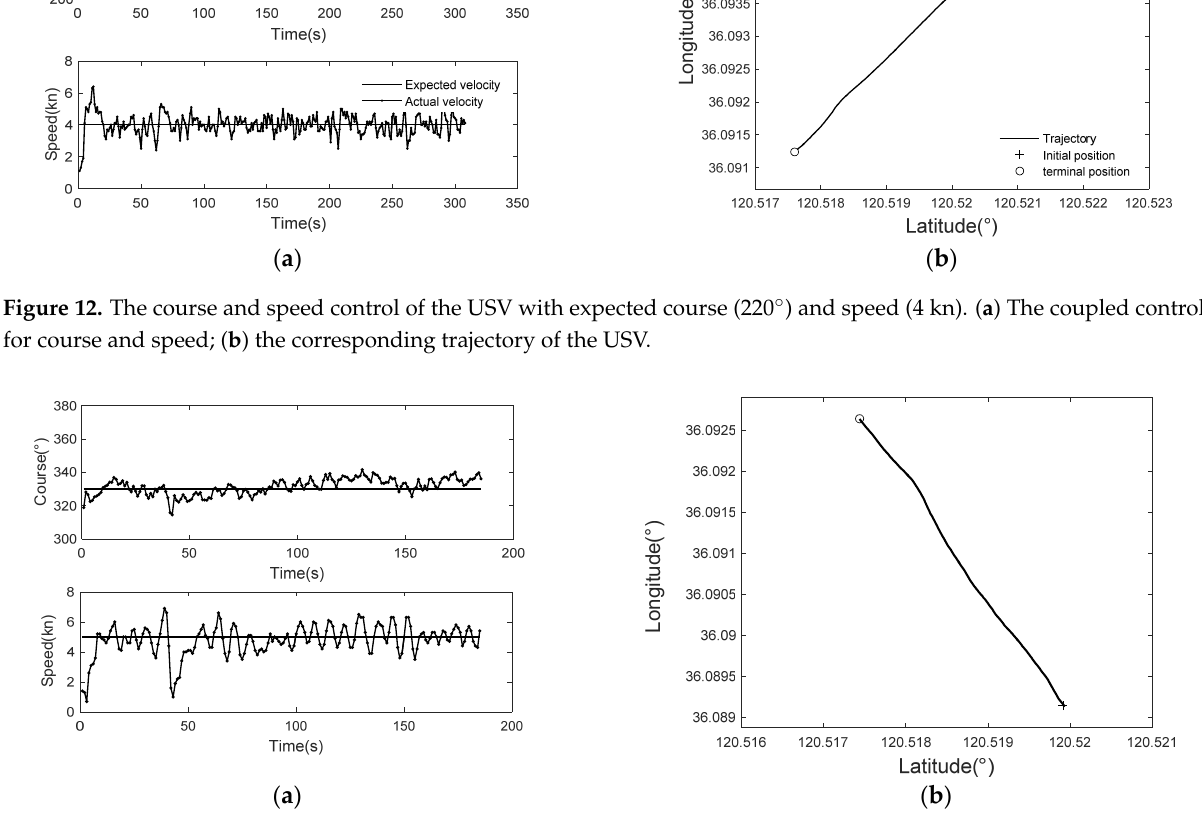
Figure 13. The course and speed control of the USV with expected course (330°) and speed (5 kn). ( a ) The coupled control for course and speed; ( b ) the corresponding trajectory of the USV.